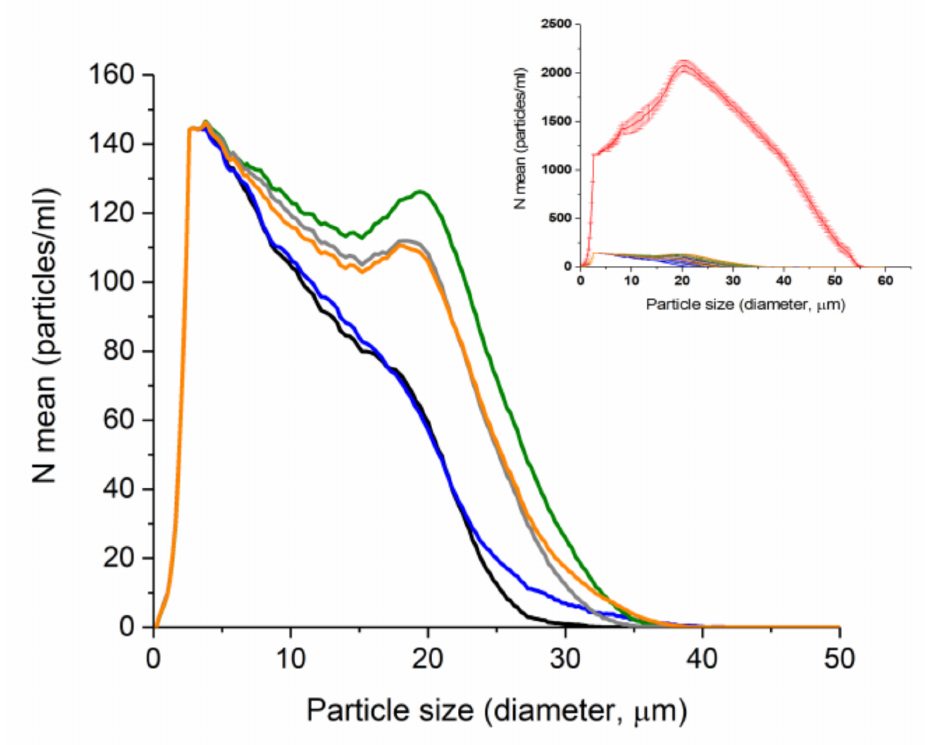
Figure 4. Comparison of the tested Zn(AA)2 complexes according to their inhibition influence on E. coli biofilm formation ( n = 3), black—Zn(Ala) 2 , blue—Zn(Met) 2 , green—Zn(Val) 2 , grey—Zn(Gly) 2 , orange—Zn(Phe) 2 . Insert shows mean numerical particle size distribution for control (red) and test solutions of zinc amino acid complexes with SD ( n =